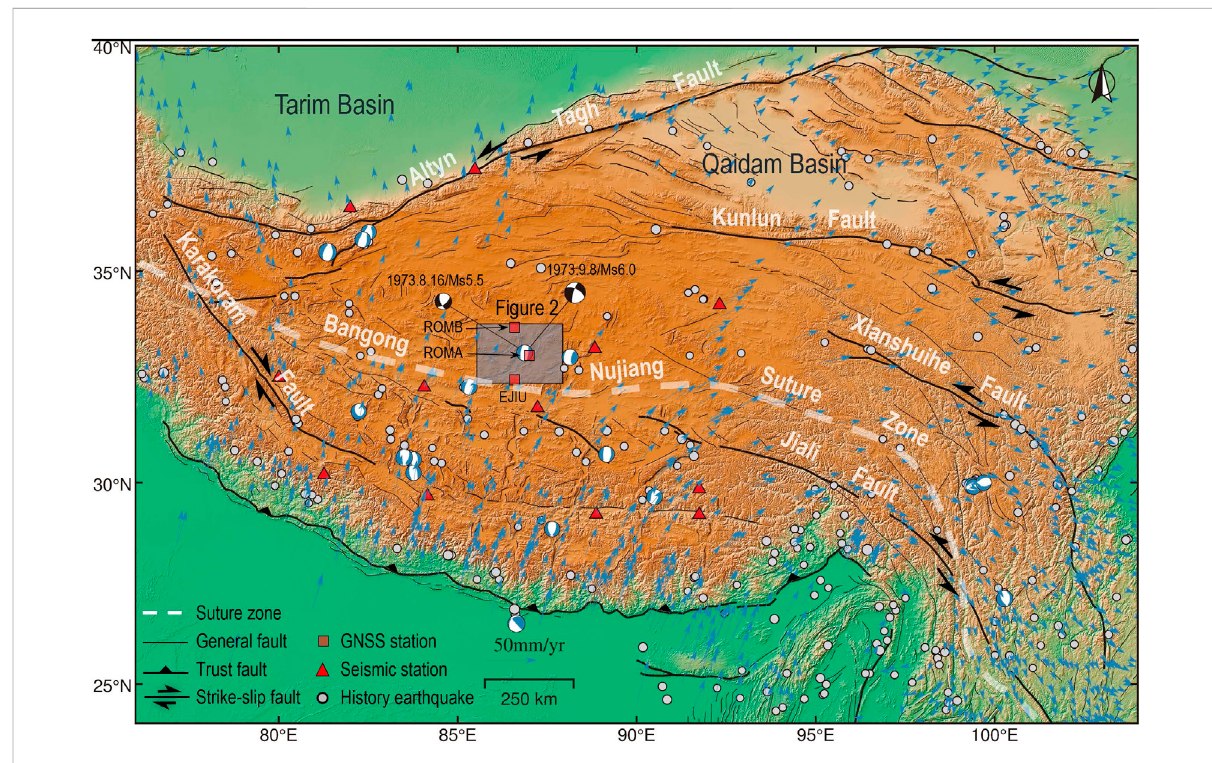
FIGURE 1 Topographic and tectonic setting map of the Tibetan plateau overlain. Light-blue circles, white and blue beach balls denote earthquakes with magnitude larger than Mw 4.5 and focal mechanisms of Mw ≥ 6 normal faulting earthquakes from 1 January 1966 to 1 April 2021 from the GCMT catalog, respectively. Black and white beach balls denote focal mechanisms of Ms ≥ 5.5 earthquake in 1973 (Molnar and Tapponnier, 1978). Red triangles denote the seismic stations used in this study. Black rectangles depict footprints of this study area. Black lines indicate regional active faultsfromTapponnier(Tapponnier etal.,2001).BluearrowsindicatesGPSvelocitiesfromWang(WangandShen,2020).Thrustfaultshavebarbson the upper plate, arrows indicate the direction of horizontal motion for strike-slip faults. The dashed white line is the Bangong Nujiang suture